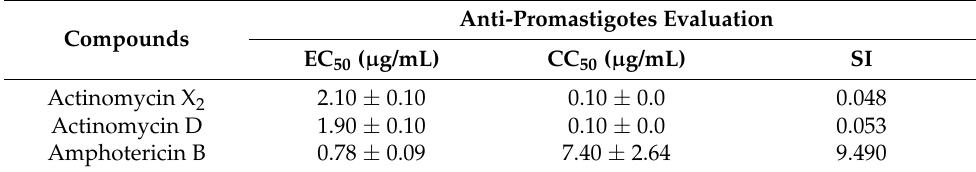
Table 1. Anti-promastigotes activity of tested compounds.